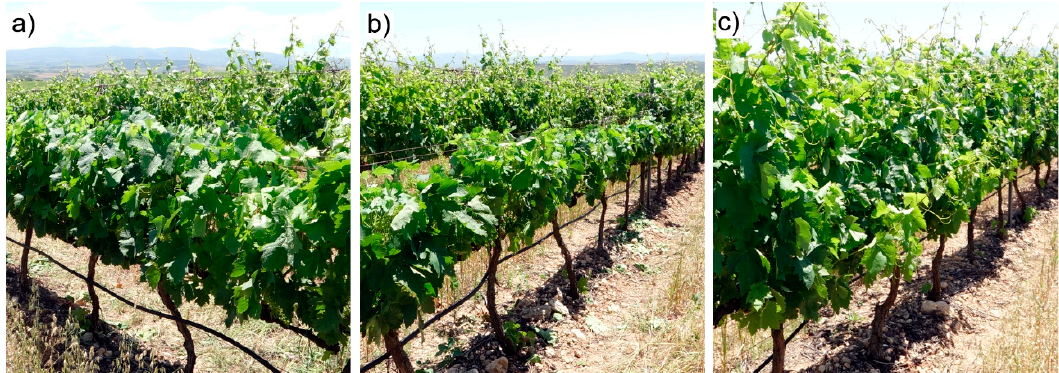
Figure 5. Pictures after shoot trimming intensity experiment in Ausejo: ( a ) low intensity shoot trimming (ST-LI), ( b ) high intensity shoot (ST-HI), ( c ) control vines.